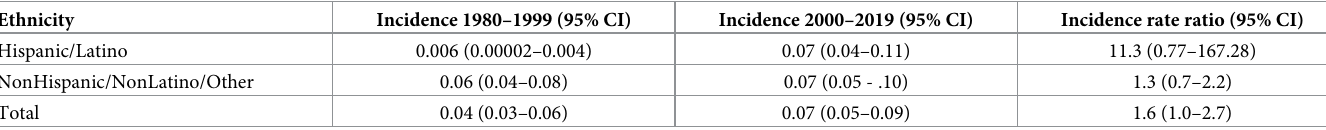
Table 2. Incidence of RMSF cases per million persons by ethnicity, using ethnicity-specific population estimates, 1980–2019. The Incidence rate ratio compares the ethnicity specific incidence between 2000–2019 (numerator) and 1980–1999 (denominator) and is a measure of excess risk between the two reporting blocks.